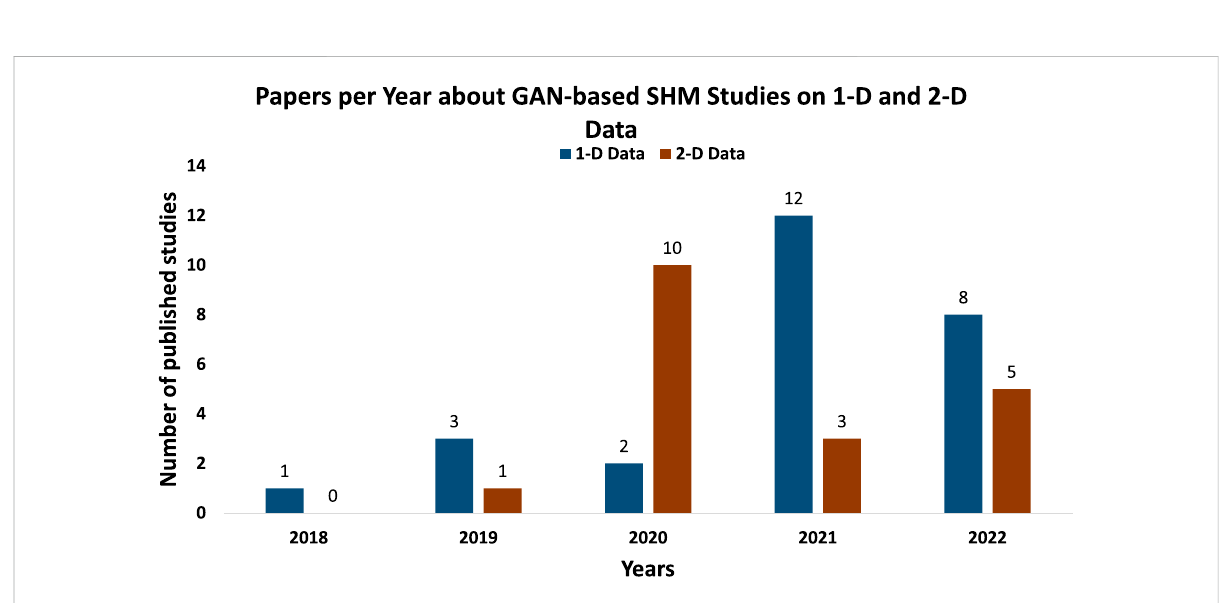
FIGURE 8 The number of papers per year included in this study (GAN-based SHM studies on 1-D and 2-D